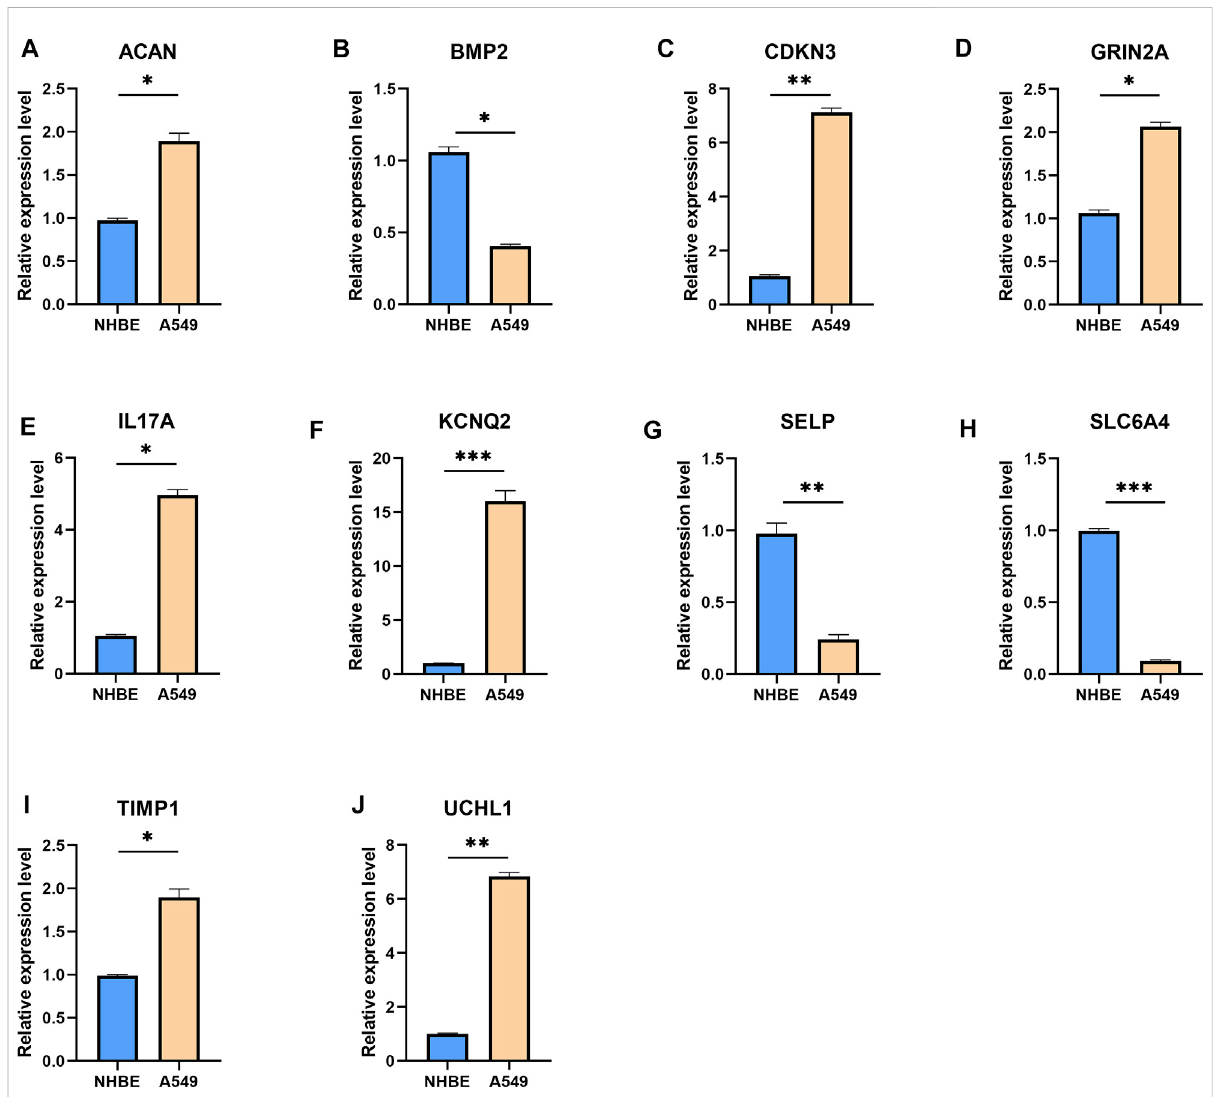
FIGURE 2 qRT-PCR results for the top 10 genes with the most signi fi cant expression differences. The mRNA expression levels of ACAN (A) , BMP2 (B) , CDKN3 (C) , GRIN2A (D) , IL17A (E) , KCNQ2 (F) , SELP (G) , SLC6A4 (H) , TIMP1 (I), and UCHL1 (J) . Expression levels of the 10 genes were normalized against GAPDH expression. * p < 0.05, ** p < 0.01, *** p <